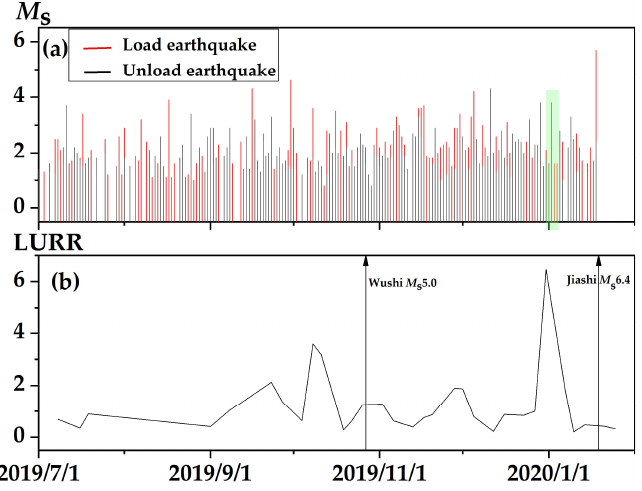
Figure 7. The seismic activity and its LURR anomaly development and change within 100 km of the epicenter before the Jiashi earthquake. ( a ) M-T time series, where the green area is the loading earthquake enhancement time; The red vertical line indicates the loading earthquake, and the black vertical line indicates the unloading earthquake. ( b ) Computed LURR evolution sequence. The arrow indicates the time of earthquake occurrence. The spike at the end of ( a ) is the 18 January 2020 M s 5.4 Jiashi earthquake which is the foreshock of the Jiashi M s 6.4 earthquake. This earthquake is not included in the calculation of LURR and has no impact on the LURR anomaly.